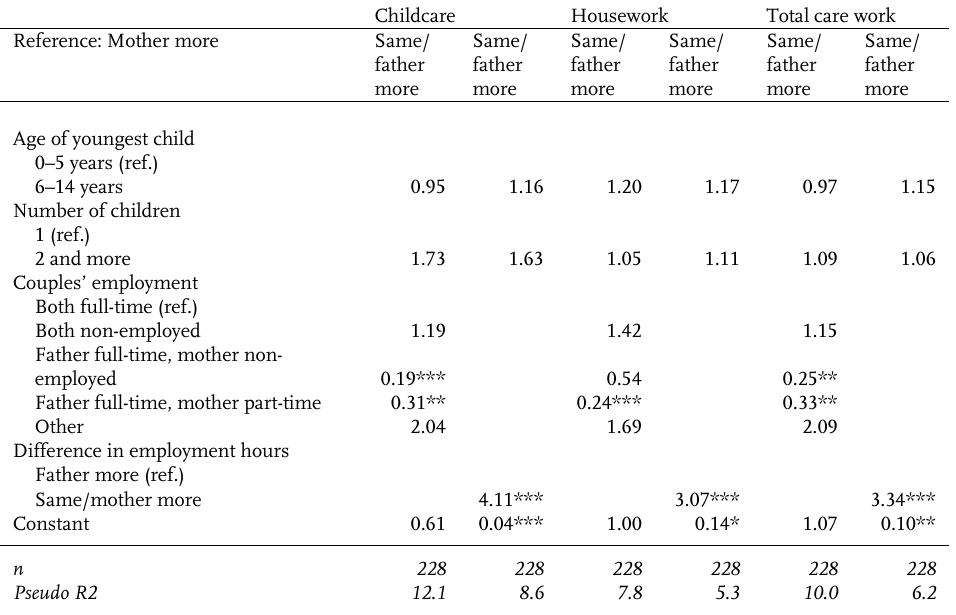
Table 6: Predictors of childcare, housework, and total care work distribution in couples, May 2020, logistic regression models (odds ratios) Childcare Housework Total care